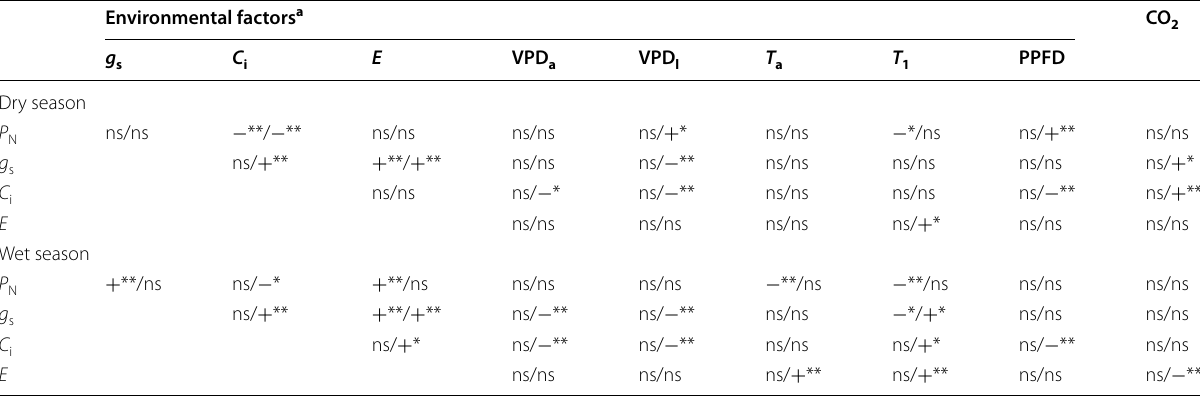
and symbols represent positive and negative correlation, respectively + − ns indicates no significant correlation * , ** Indicate significance at P < 0.05 and P < 0.01, respectively. N a g s (stomatal conductance), C i (intercellular CO 2 concentration), E (transpiration rate), VPD a (air vapor pressure deficit), VPD l (leaf-air vapor pressure deficit), T a (air temperature), T l (leaf temperature), PPFD (photosynthetic photon flux density), CO 2 (ambient CO 2 concentration), S. macrophylla / M. azedarach